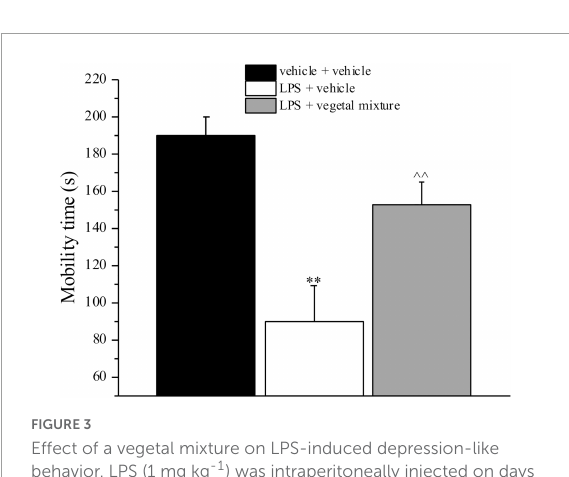
FIGURE3 Effect of a vegetal mixture on LPS-induced depression-like behavior. LPS (1 mg kg - 1 ) was intraperitoneally injected on days 1, 3, 5, and 8. The vegetal mixture was composed of Zingiber officinale (150 mg kg - 1 ), Echinacea purpurea (20 mg kg - 1 ), and Centella asiatica (200 mg kg - 1 ), suspended in 1% carboxymethylcellulose sodium salt (CMC) and orally administered daily starting from day 1 till the end of the